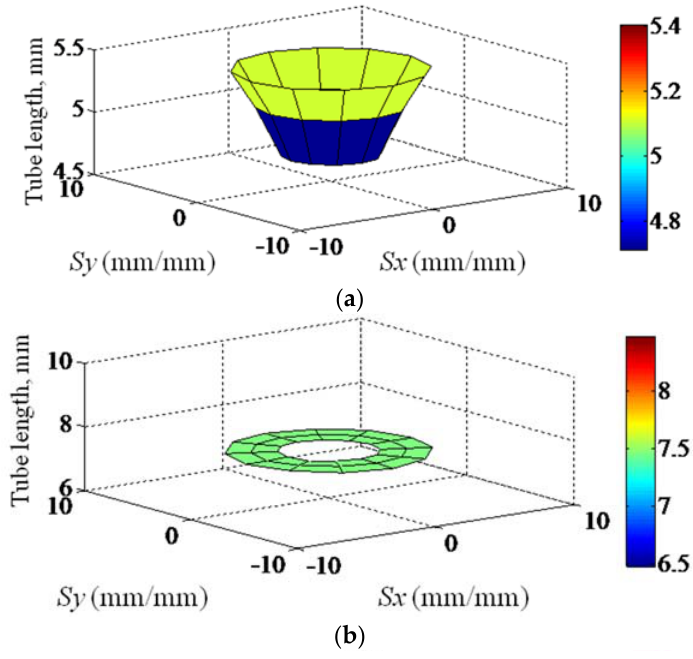
of cavity and tubes of the block element provides the acoustic impedance value b Z in specific u e , directions, respectively. Appl. Sci. 2017 , 7 , 456 e , and e directions, respectively. v w